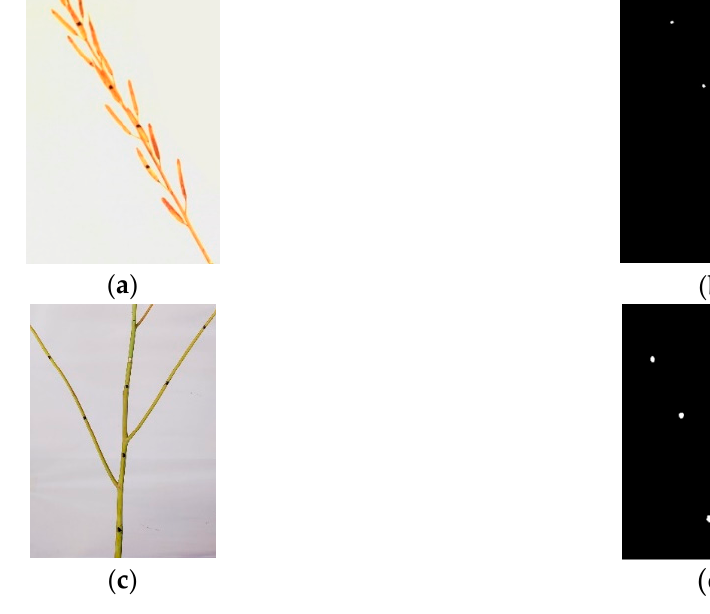
Figure 5. Figures of rape plant’s measurement point marks and threshold segmentation. ( a ) Image of rape pods marked feature points. ( b ) Threshold segmentation image of rape pods. ( c ) Image of rape branches marked feature points. ( d ) Threshold segmentation image of rape branches.